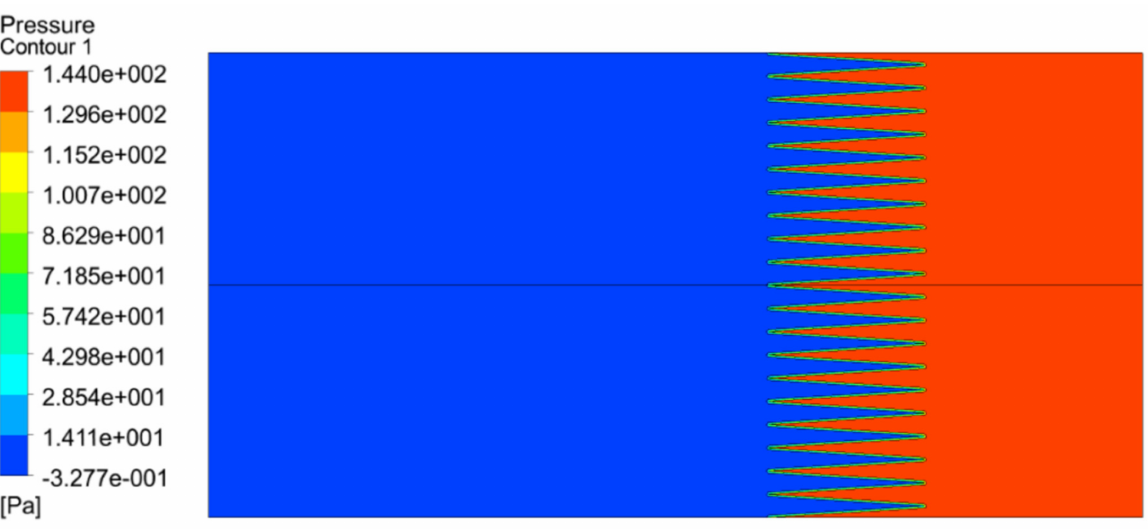
Figure 8. Static pressure distribution in the symmetry